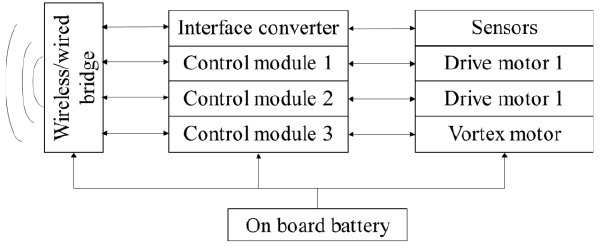
Figure 18. Control system.